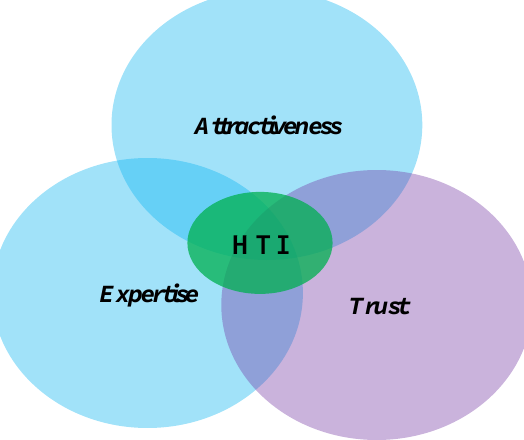
Figure 4. Configuration 1 (C.1) Contributes to High Travel Intention (HTI)